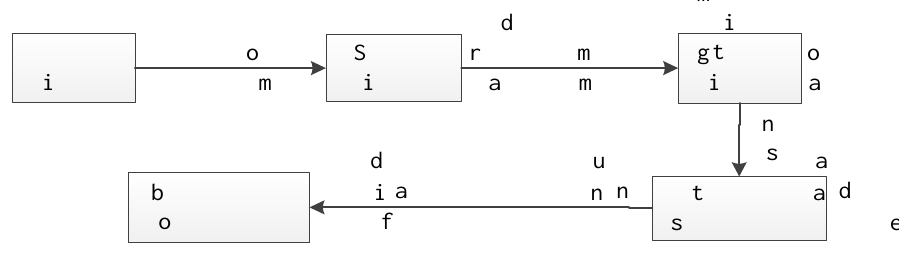
Figure 2. Canny operator edge extraction